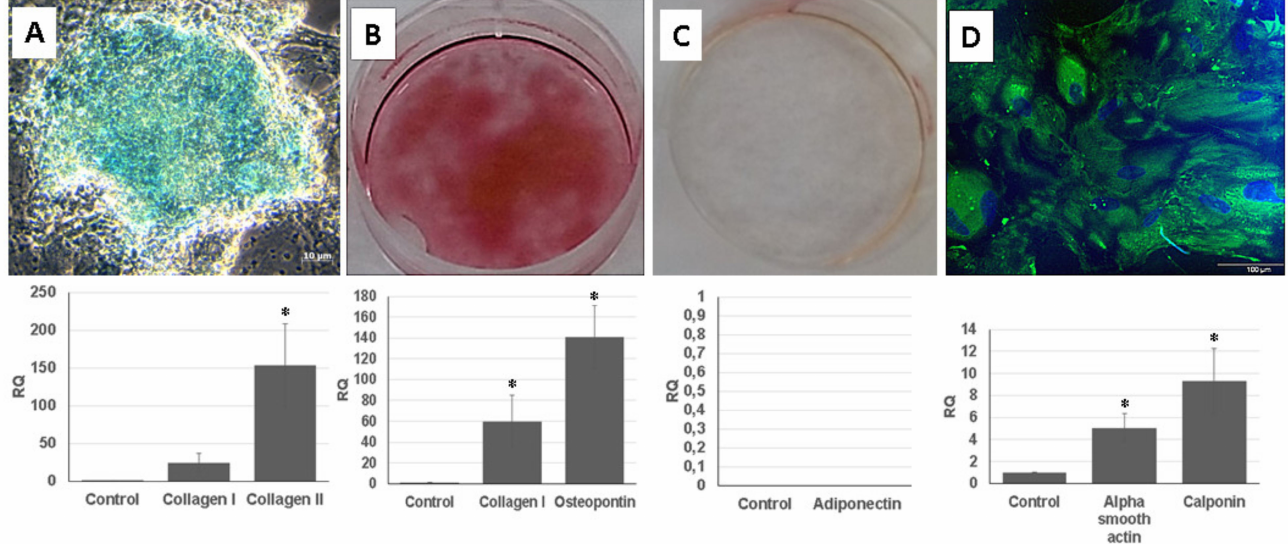
Figure 5. Multilineage differentiation of human UDSCs. ( A ) Chondrogenic differentiation. Image depicting glycosamino- glycan deposits which were formed after 28 days of induction in specific differentiation media. Results obtained from RT-PCR also confirmed high expression of collagen I and collagen II (* p < 0.05). ( B ) Alizarin Red was applied to stain calcium nodules and thereby determine the successful osteogenic induction. RT-PCR analysis revealed significantly higher expression levels of collagen I and osteopontin when compared to the control group (* p < 0.05). ( C ) Oil Red O staining together with RT-PCR were applied in order to assess successful adipogenic differentiation. However, isolated UDSCs did not differentiate into this cell lineage. ( D ) UDSCs induced into smooth cell lineage. Specific marker myosin (green) was confirmed by immunofluorescence. Nuclei were stained with DAPI. Moreover, significantly higher expression of alpha smooth actin and calponin I was detected as well (* p <